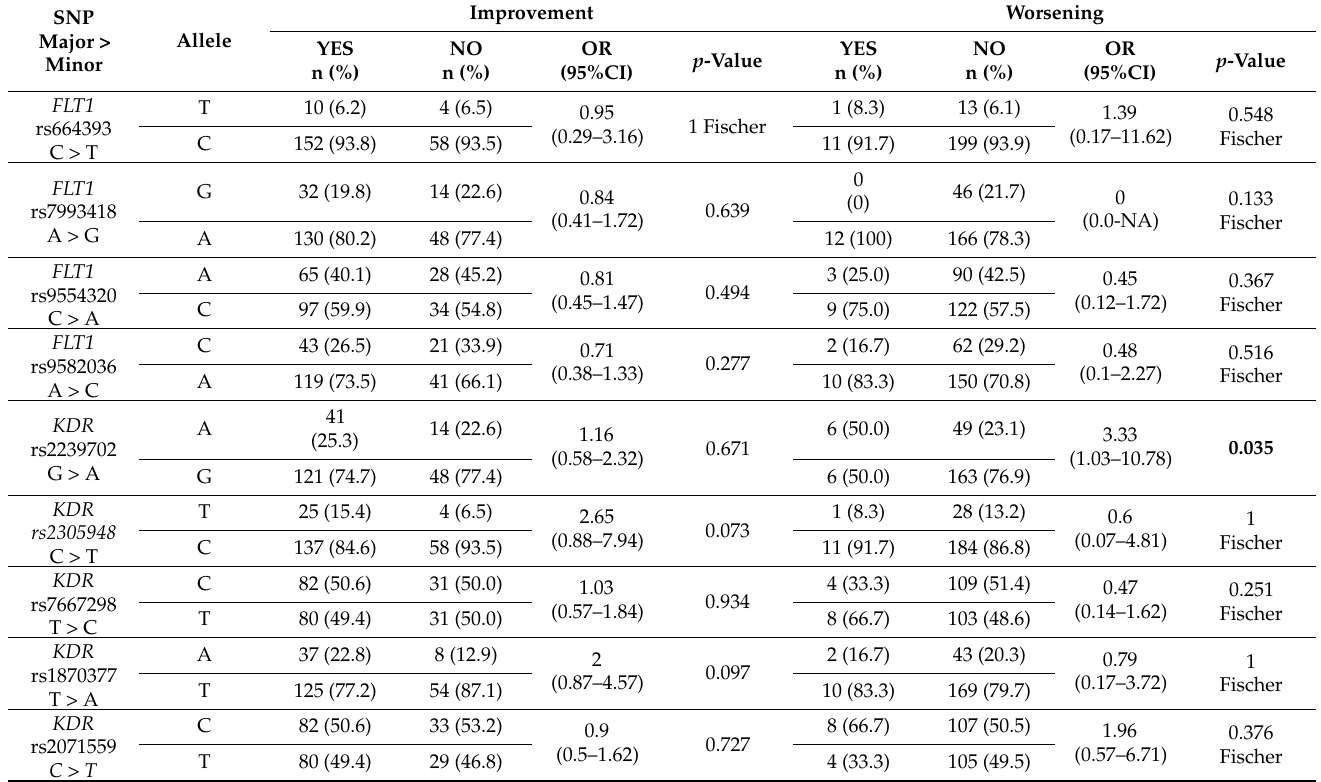
Table 5. Alleles association study with BCVA improvement/worsening at 12